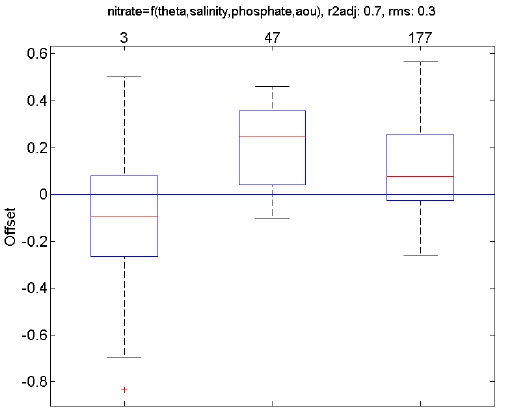
Figure 11. MLR results for NO 3 in the Nansen Basin (o ff sets in µ molkg − 1